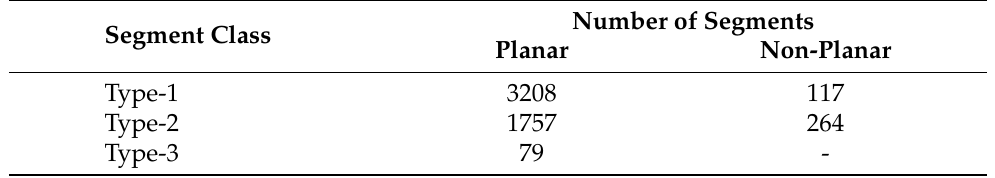
Table 2. Shape classification results for planar and non-planar segments.